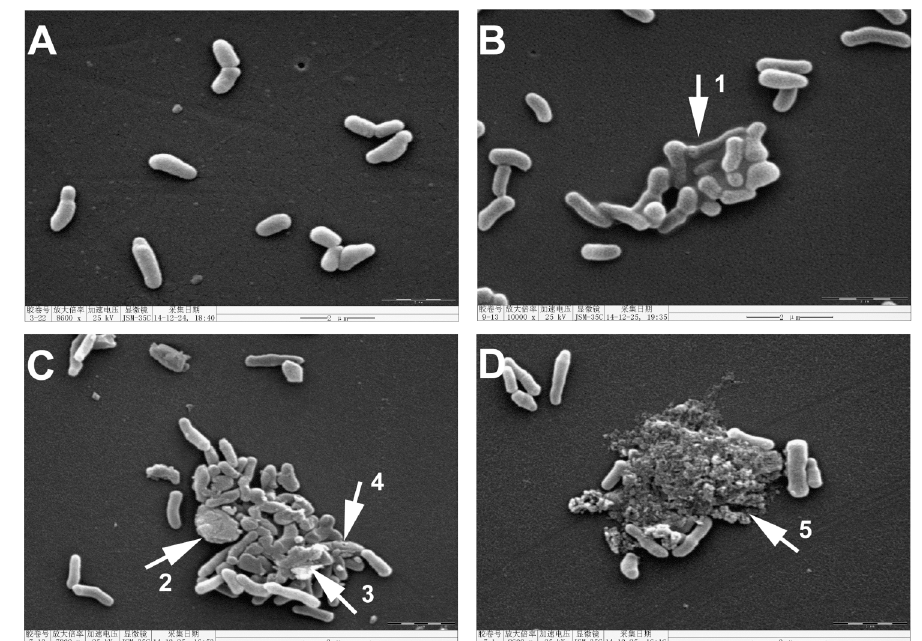
Fig. 3 : Scanning electron microscopy of Clavibacter michiganensis subsp. michiganensis cells exposed to Laminaria japonica extracts. (A)-Untreated cells (8600x); (B)-Cells after exposure to L. japonica extracts at 0.03 mg/mL (10000x); (C)-Cells after exposure to L. japonica extracts at 0.04 mg/mL (7800x); (D)-Cells after exposure to L. japonica extracts at 0.05 mg/mL (8600x). Arrows indicated: 1, protoplast leakage; 2, clumped cells; 3, col- lapsed surfaces; 4, misshapen cells; 5, cell